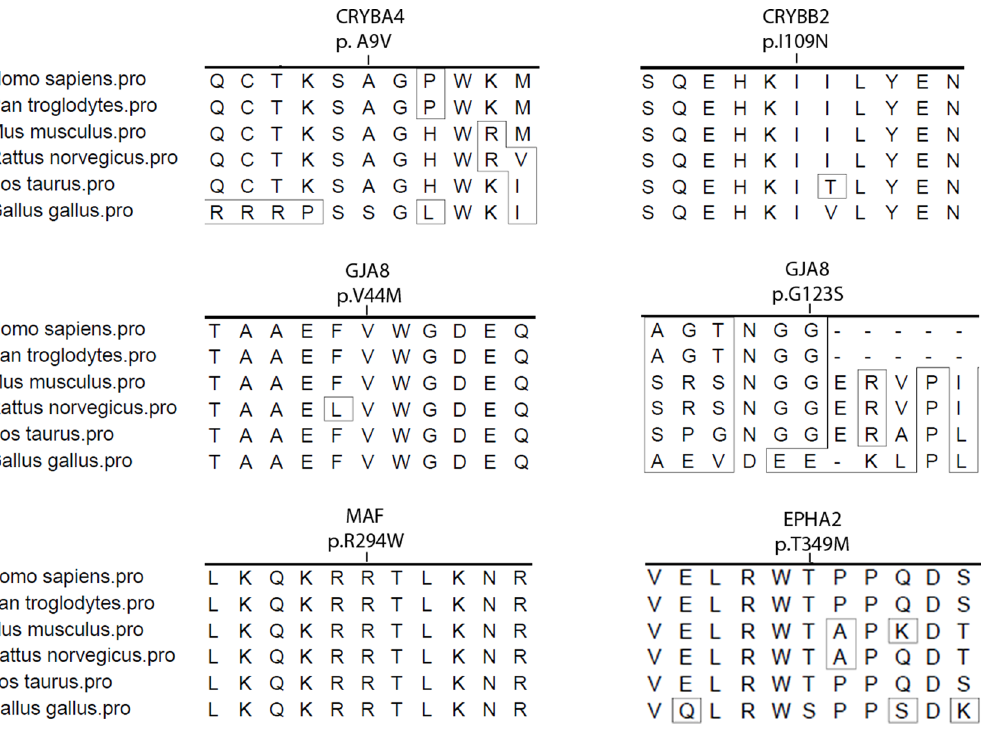
Figure 2. Conservation alignments for the five missense mutations. The amoni acid position with p.I109N in CRYBB2, p.V44M in GJA8 , and p.R294W in MAF are highly conserved, while the p.A9V in CRYBA4, the p.T349M inEPHA2, and the p. G123S in GJA8 are not highly conserved.